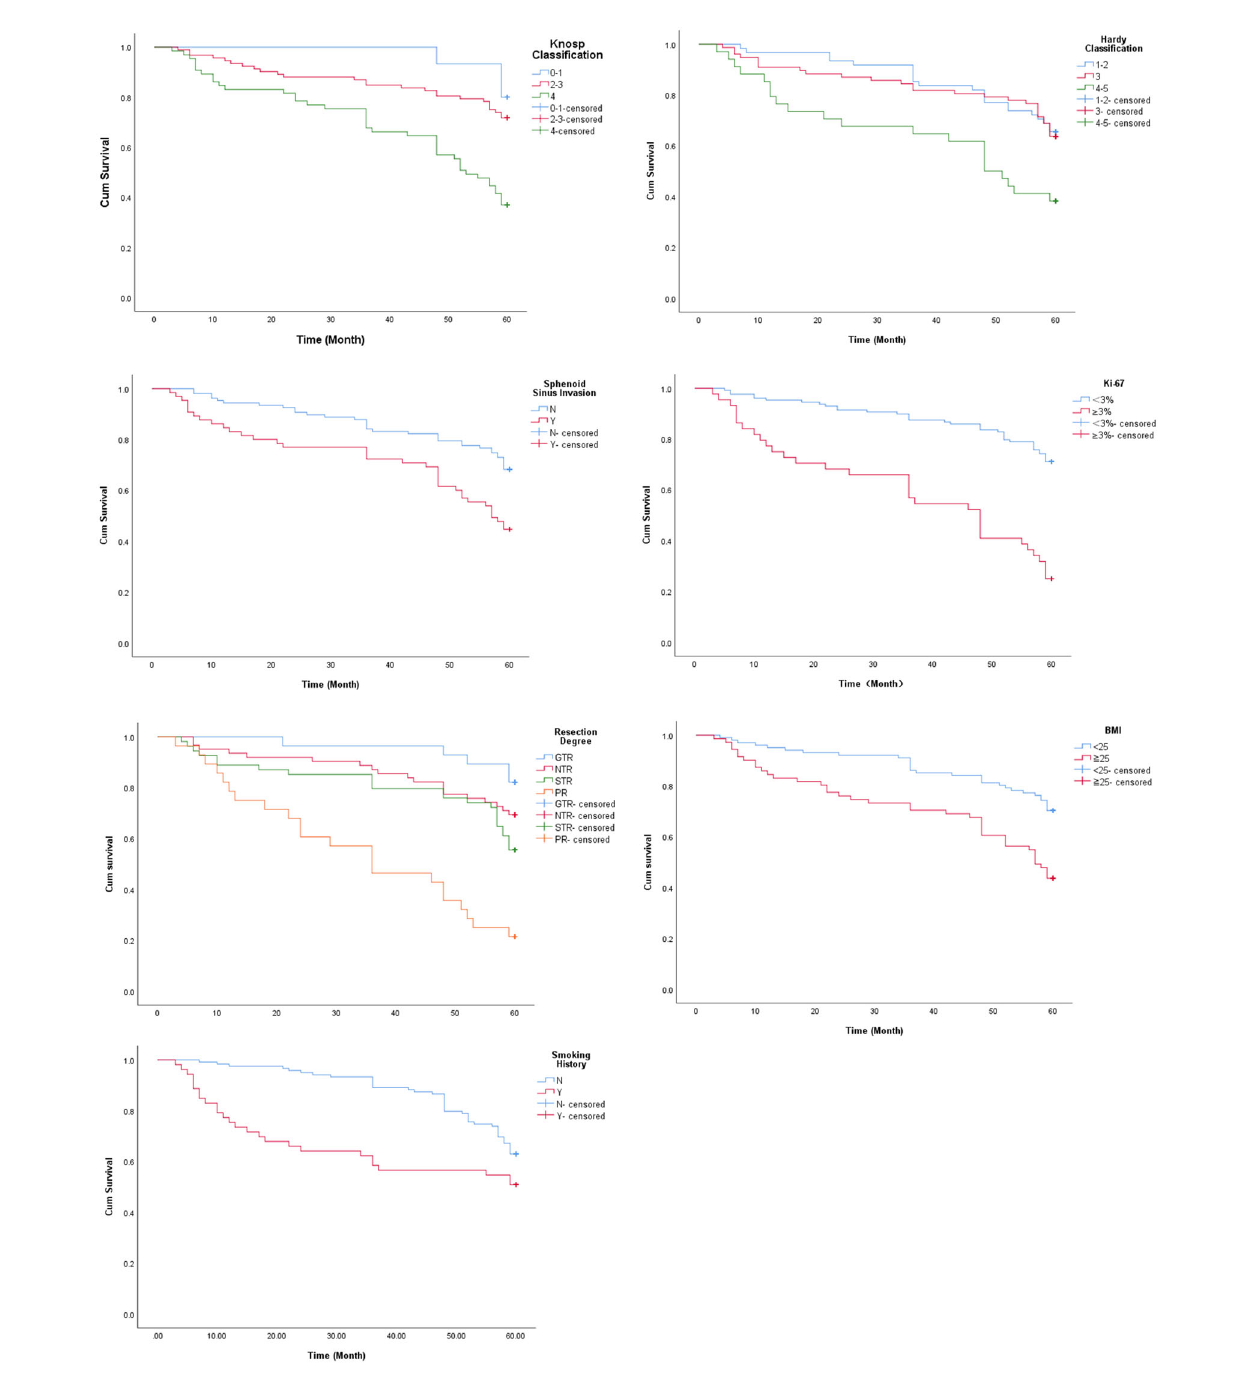
FIGURE 2 | Survival curves of patients strati fi ed on the basis of Knosp classi fi cation, Hardy classi fi cation, sphenoid sinus invasion, Ki-67, extent of resection, BMI and smoking